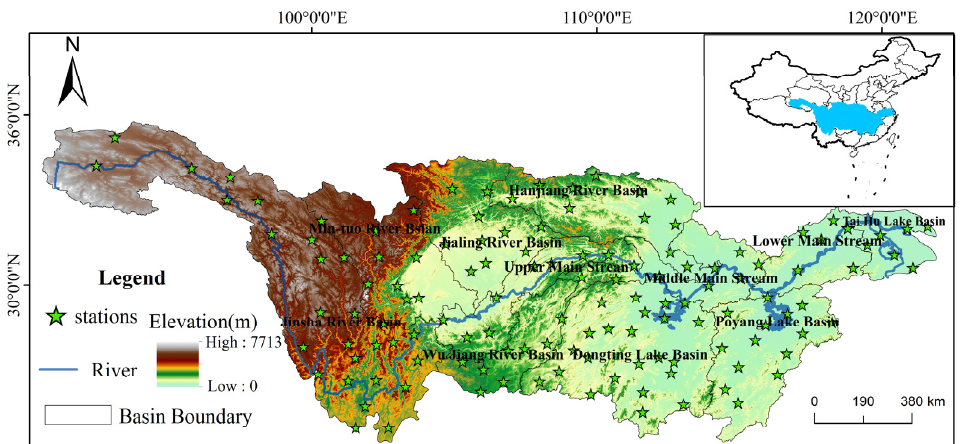
Figure 1. Location, basin boundaries, altitudinal variation range, and distribution of the meteorological stations in the Yangtze River Basin, China.